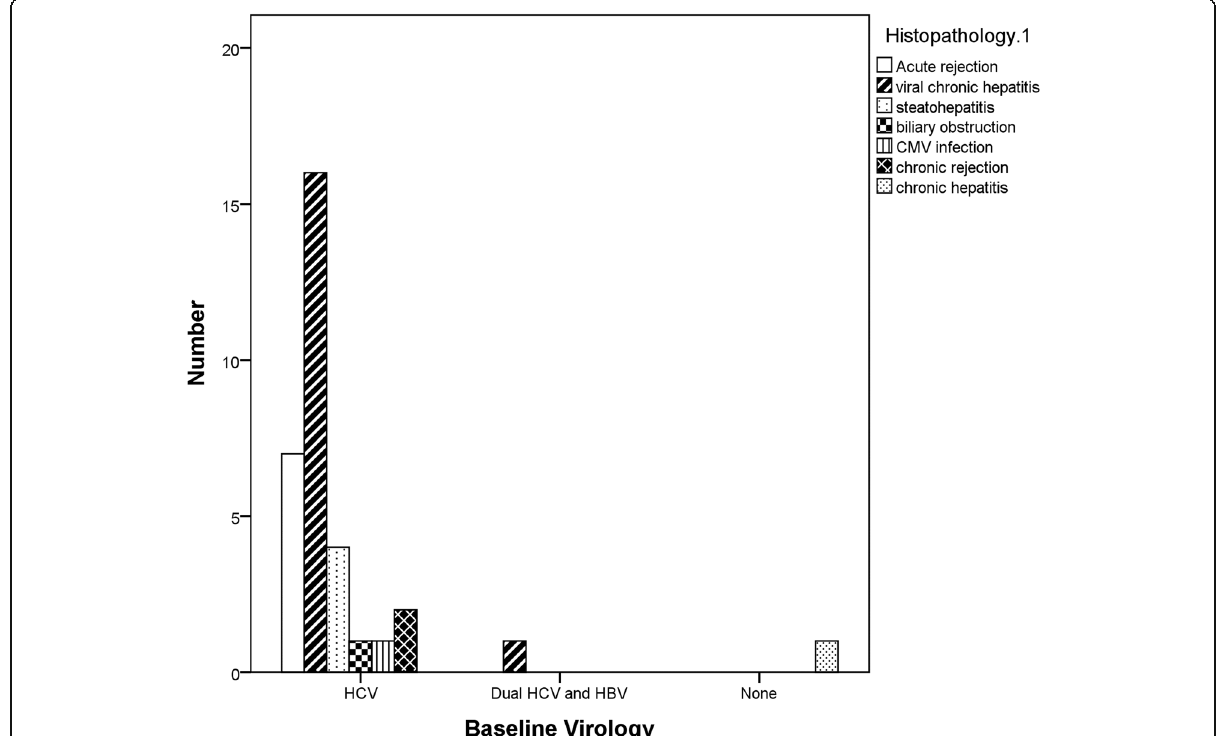
Fig. 3 Correlations between the indication of liver transplantation and the histopathology